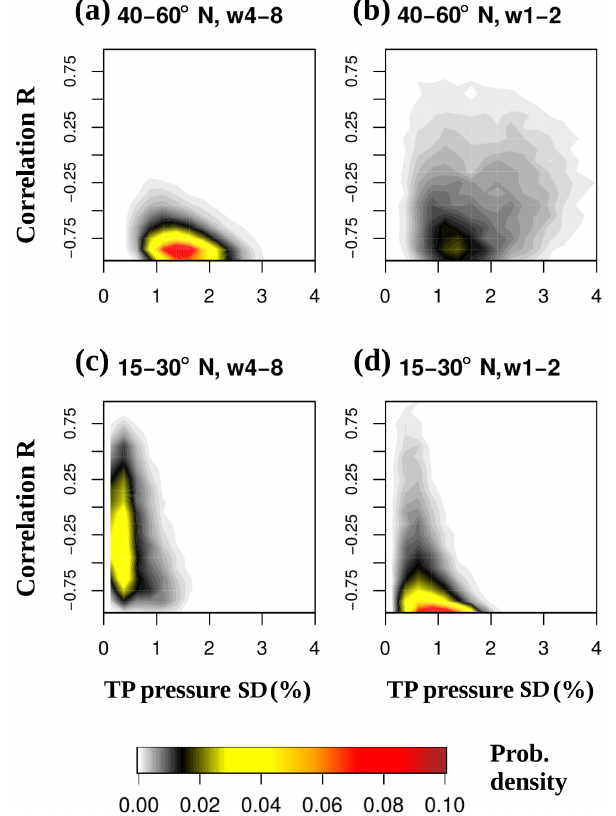
Figure 11. Probability density functions of the UT–LS temperature correlation vs. wave amplitudes for RWPs (w4–8, a , c ) and plan- etary waves (w1–2, b , d ) at midlatitudes (a, b) and the subtropics (c, d) .